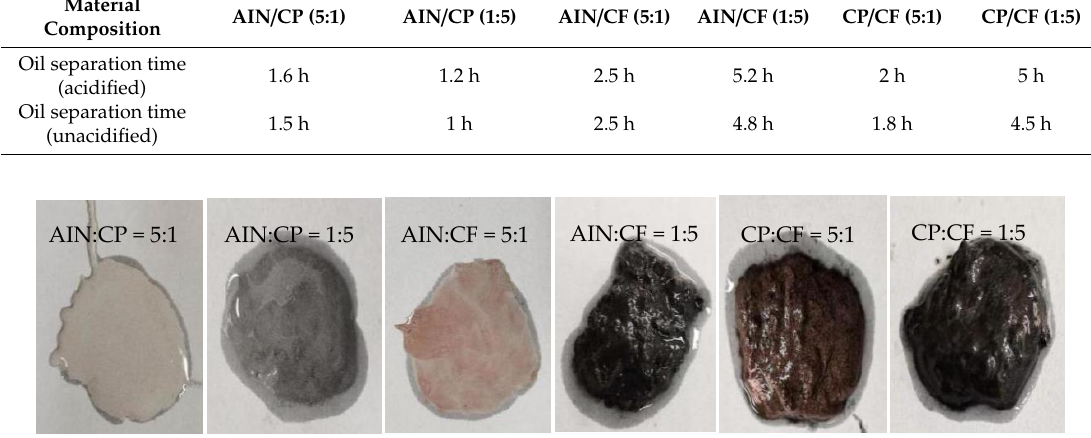
Figure 12. Physical image of oil separation after heating TSG.